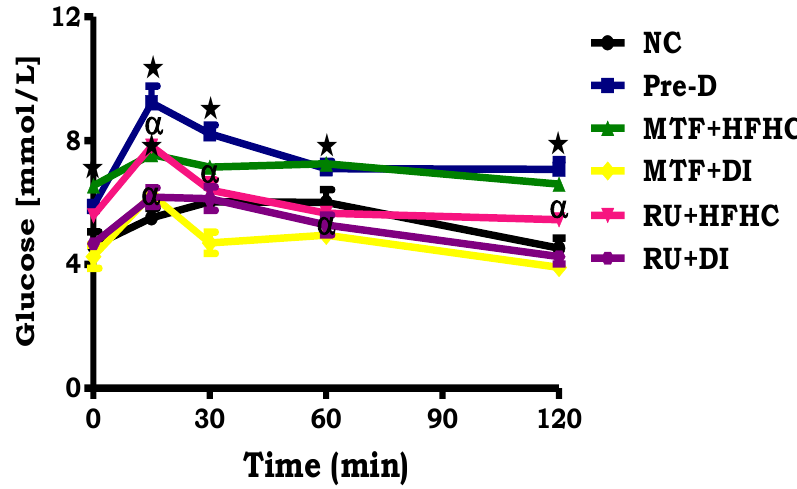
Figure 3. The effects of the ruthenium complex on OGTT of pre-diabetic animals. Values are presented as means ± SEM ( n = 6) in each group. * p < 0.05 by comparison with normal control (NC), α p < 0.05 by comparison with pre-diabetic control (Pre-D); Metformin and high fat high carbohydrate (MTF + HFHC); Metformin and diet intervention (MTF + DI); Ruthenium and high fat high carbohydrate (RU + MTF); and Ruthenium and diet intervention (RU + DI).